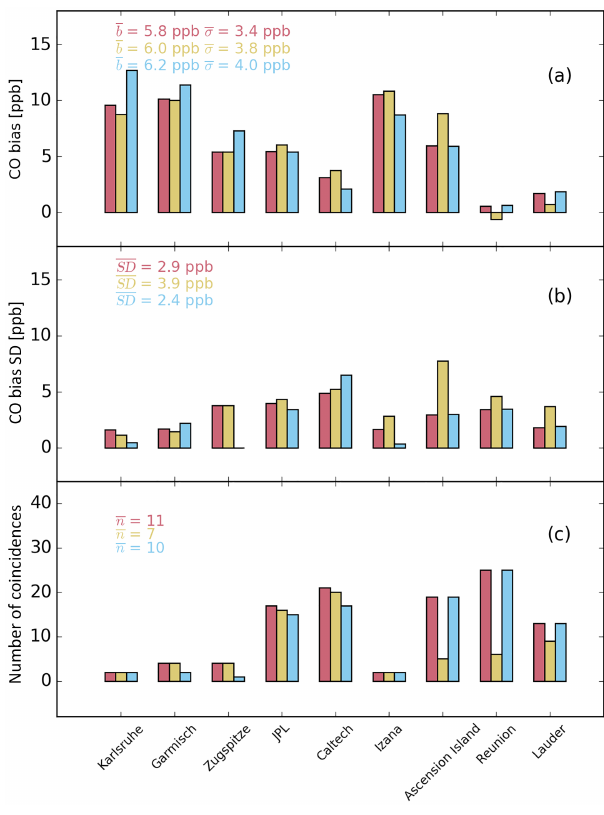
Figure 5. Mean bias (TROPOMI – FTS) between co-located daily mean XCO values (see Figs. 3, 4) of TROPOMI and TCCON (a) , the standard deviation of the bias (b) , and the number of coincident daily mean pairs (c) . b is the global mean bias (average of all sta- tion biases) and σ its standard deviation. SD is the average of all standard deviations and n the average number of coincident pairs. TROPOMI retrievals under clear sky (yellow), cloudy sky (blue) and the combination of both (pink) are distinguished. No de-striping was applied on the TROPOMI